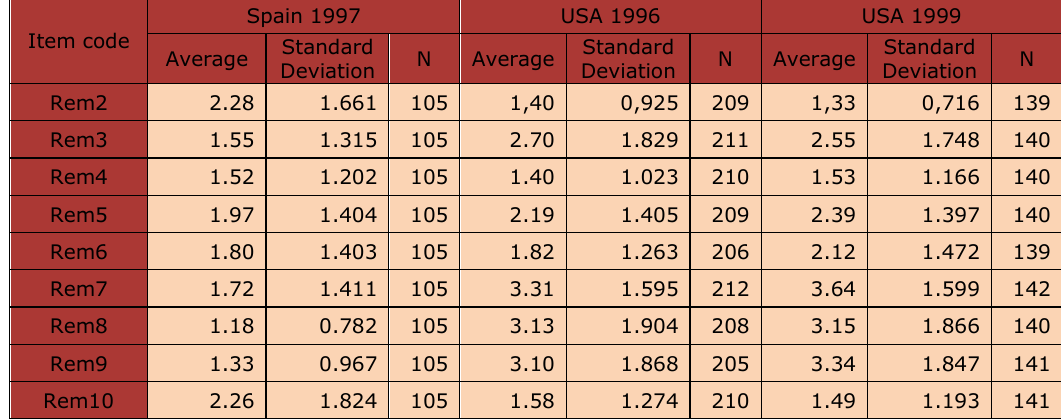
Table 8. Rewards